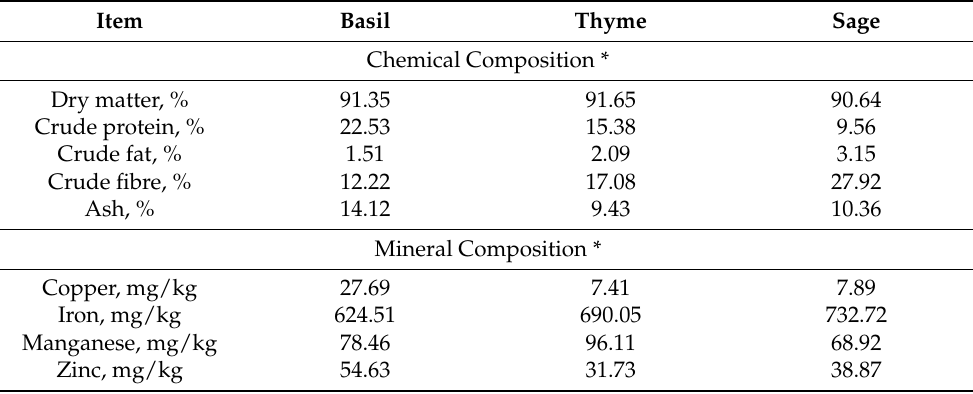
Table 1. Nutritional and mineral composition of the